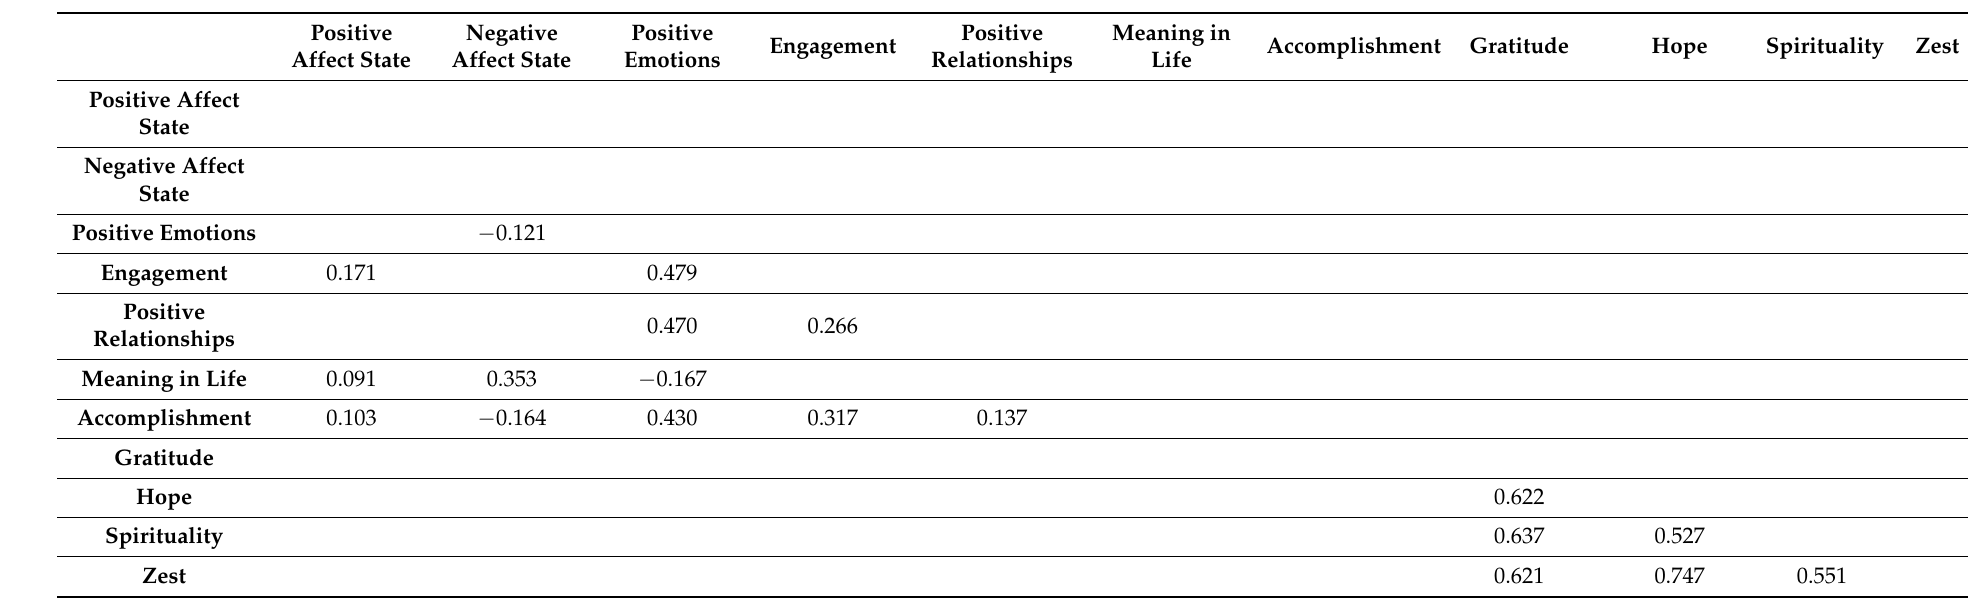
Table 5. Correlations between transcendent virtue dimensions and subjective wellbeing